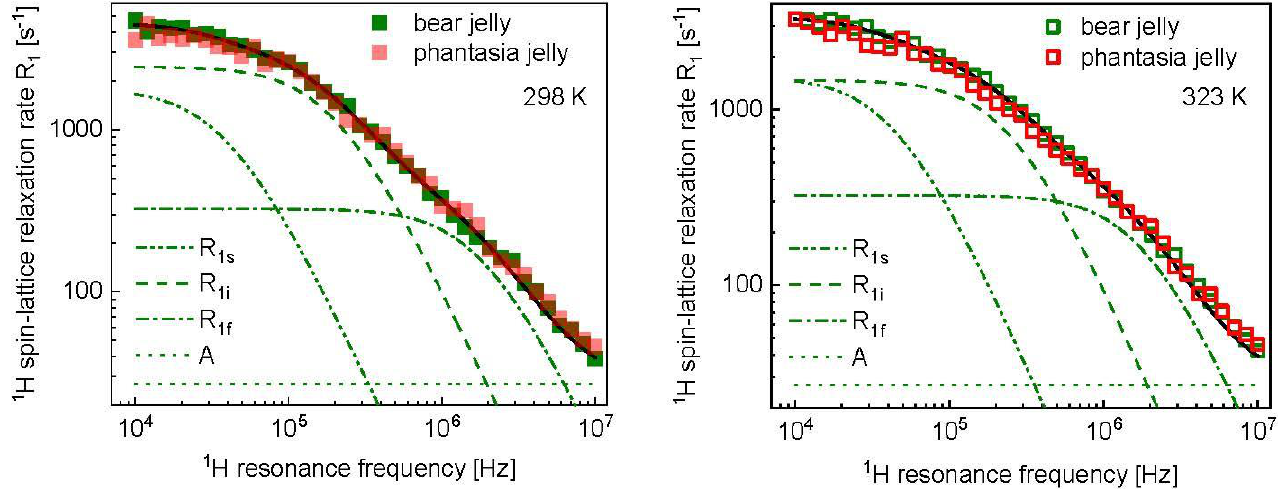
Figure 3. 1 H spin-lattice relaxation data for Haribo bear jelly and Haribo phantasia jelly at 298 K ( left ) and 323 K ( right ) reproduced in terms of the model described in the theory. The fit ( R 1 ) shown as a black solid line has been decomposed into relaxation contributions associated with slow, intermediate and fast dynamics, R 1s , R 1i and R 1f , respectively. The frequency independent term, A , is also indicated. Table 1. Parameters characterizing molecular dynamics in Haribo jellies. C DD s = 1.46 × 108 ( ± 6.1 × 10 7 ) Hz 2 , C DD = 1.25 × 10 9 ( ± 3.2 × 10 8 ) Hz 2 and τ f = 5.21 × 10 − 8 ( ± 2.7 × 10 − 9 ) s for all f cases, except for Haribo balla raspberry jelly at 323 K, in this case 𝐶 𝑓𝐷𝐷 =1.02 × 10 9 (± 3.4 × 10 8 ) Hz 2 ; 𝜏 𝑠 at 323 K has been fixed at 2.43 × 10 − 6 s. Temp.